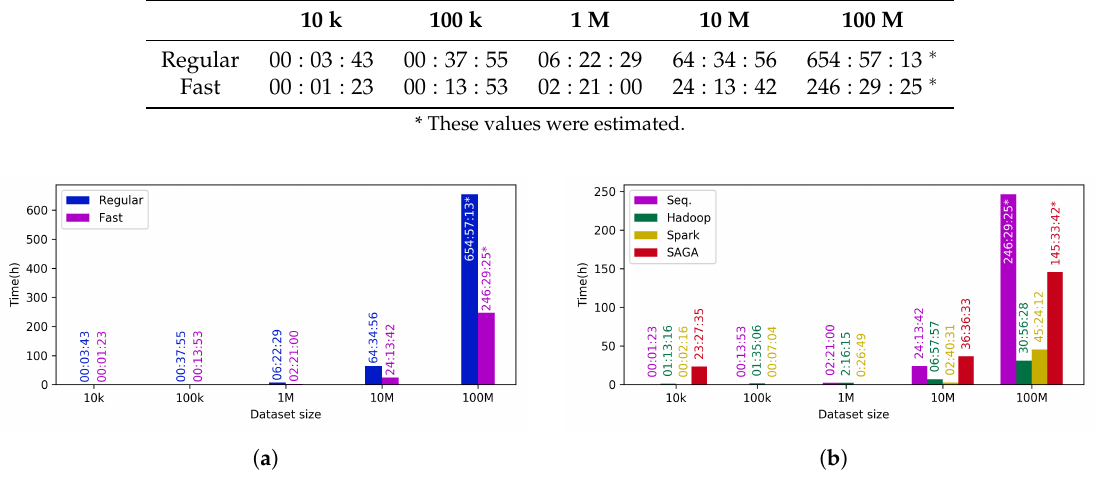
Figure 10. Performance comparison among the different Self-Organized Maps’ implementations described in Section 3. ( a ) speed up obtained by the FastSOM compared to the regular one using a sequential approach; ( b ) scalability of the FastSOM algorithm for the proposed implementations. * These values were